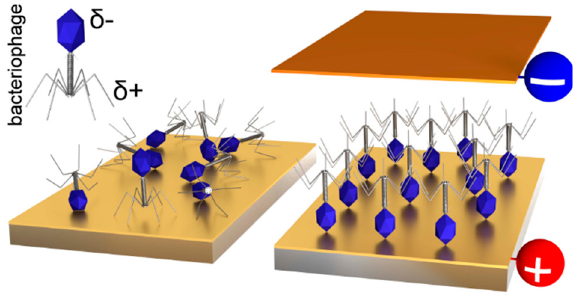
Figure 13. Scheme of the electric-field-dependent orientation of T4 bacteriophage. Without the electric filed, phage orientation is random, but, if immobilization is conducted between capacitor covers, phages are generally oriented [120]. Reprinted from [120], Copyright 2016, with permission from Elsevier.